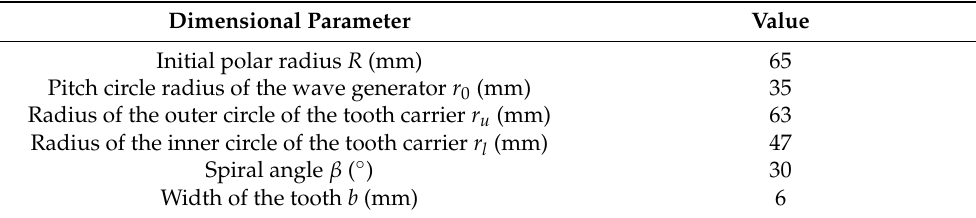
Table 1. Dimensional parameters of the prototype.